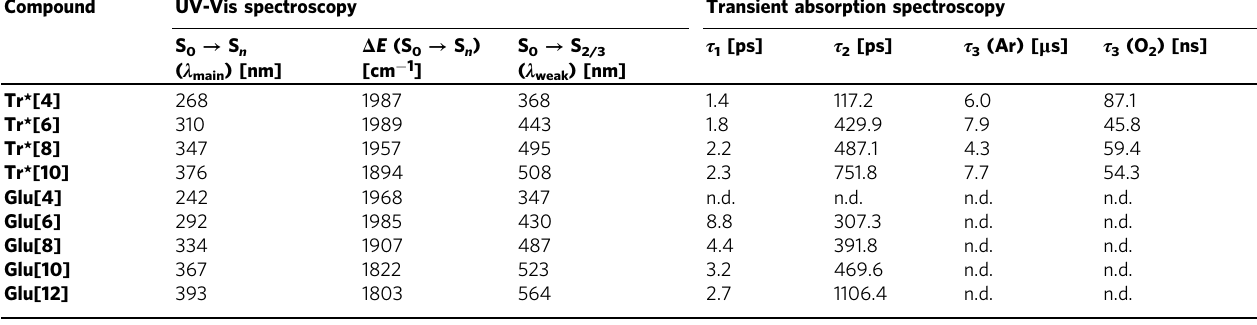
Table 1 Experimental data determined by UV-Vis absorption spectroscopy and by global analysis of the transient absorption spectra. Compound UV-Vis spectroscopy Transient absorption